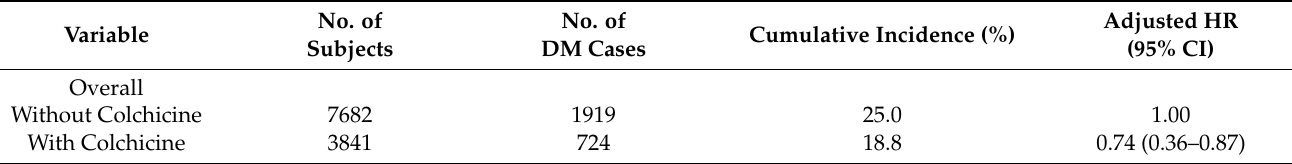
Table 2. Association between colchicine administration and risk of type 2 diabetes mellitus.